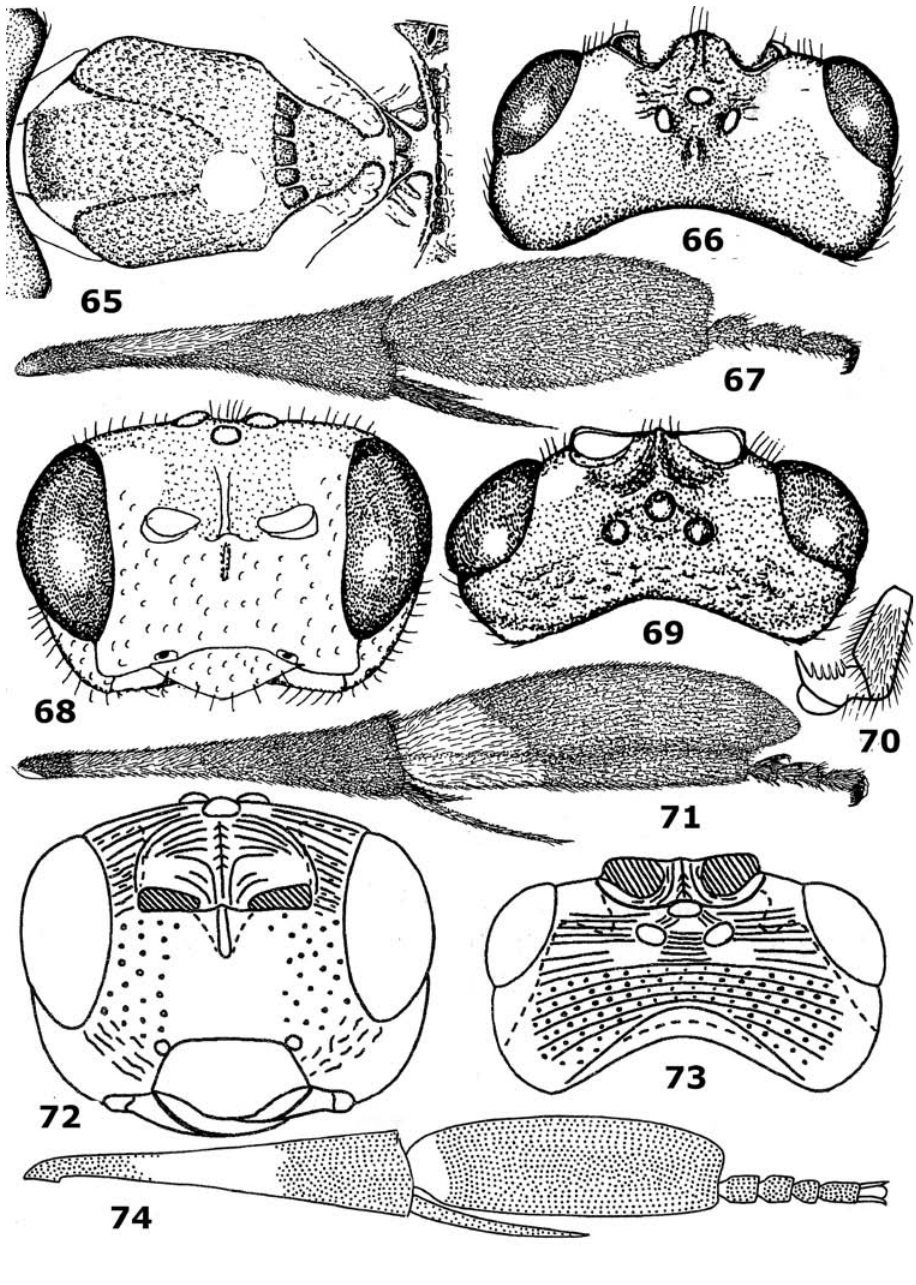
Figures 65–74. 65–67 . Hartemita bruneiensis Dangerfield & Austin, male, holotype. 68–71. H. singapo- rensis (Mao), female. 72–74. H. spasskensis Belokobylskij, female, holotype. 65 mesonotum and metano- tum dorsal 68 , 72 head frontal 66 , 69 , 73 head dorsal 67 , 71 , 74 hind tibia and tarsus lateral 70 hind tarsal claw. Figures 65–69, 71 after Dangerfield and Austin (1990) and 72–74 after Belokobylskij